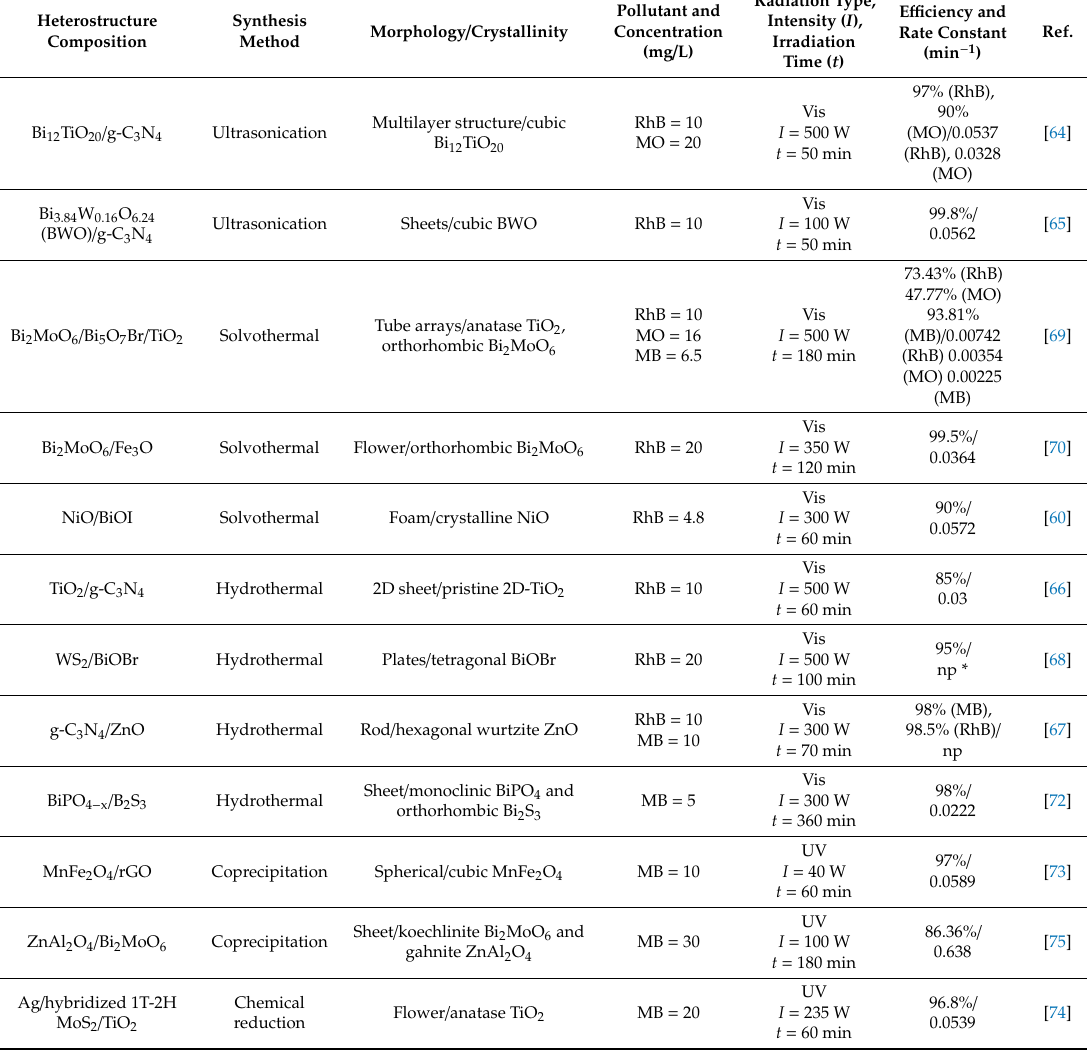
Table 1. Recent representative studies on heterostructures photocatalytic application for dyes removal. Heterostructure Synthesis Composition